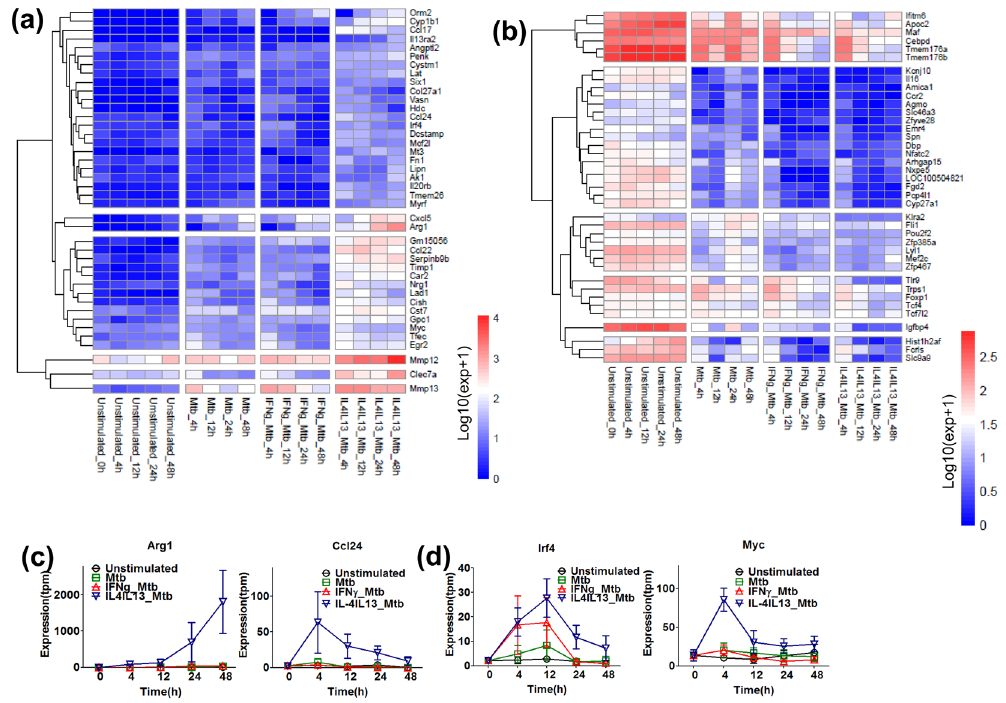
Figure 5. Mtb infection augments M2 activation in M2 pre-activated macrophages. Qualitative analysis was performed to obtain several fold elevated or suppressed genes in IL-4/IL-13_Mtb by calculating TPM expression fold change comparing expression TPM value of IL-4/IL-13_Mtb with Mtb, IFN γ _Mtb samples at each time point. IL-4/IL-13 pre-stimulation-mediated several fold up regulated (a) and suppressed or down regulated (b) non TF genes (more and less than 10-fold respectively) and TF genes (more and less than 3-fold respectively) was selected as seen in the heatmap cluster in each time point. Both heat maps shows un-stimulated control which indicate the basal level of gene expression. ( c) Expression profiles of representative M2 key effector genes, Arg1 and Ccl24 . (d) Expression profiles of representative M2 key TF genes, Irf4 and Myc